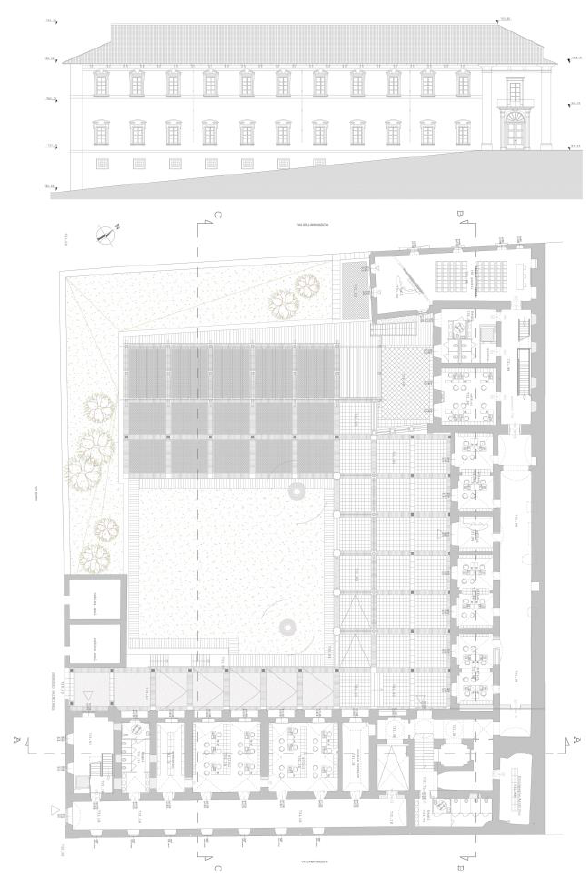
Figure 2. Survey of Camponeschi palace: first level plan and main